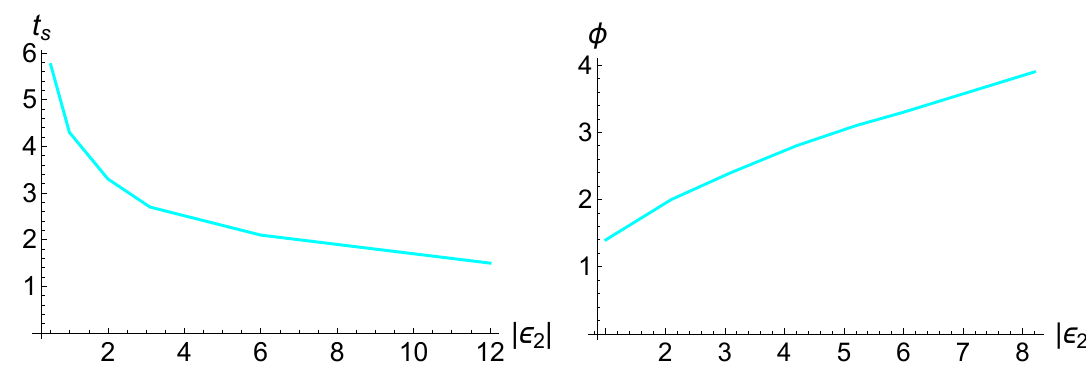
Figure 7 . Left: scrambling time ( t s ) vs | (cid:15) 2 | , Right: slope ( φ ) vs | (cid:15) 2 | .